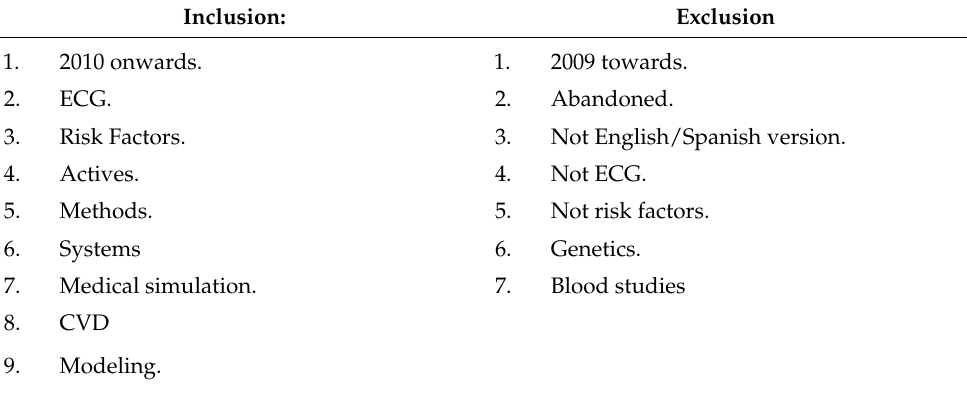
Table 1. Inclusion and exclusion criteria.